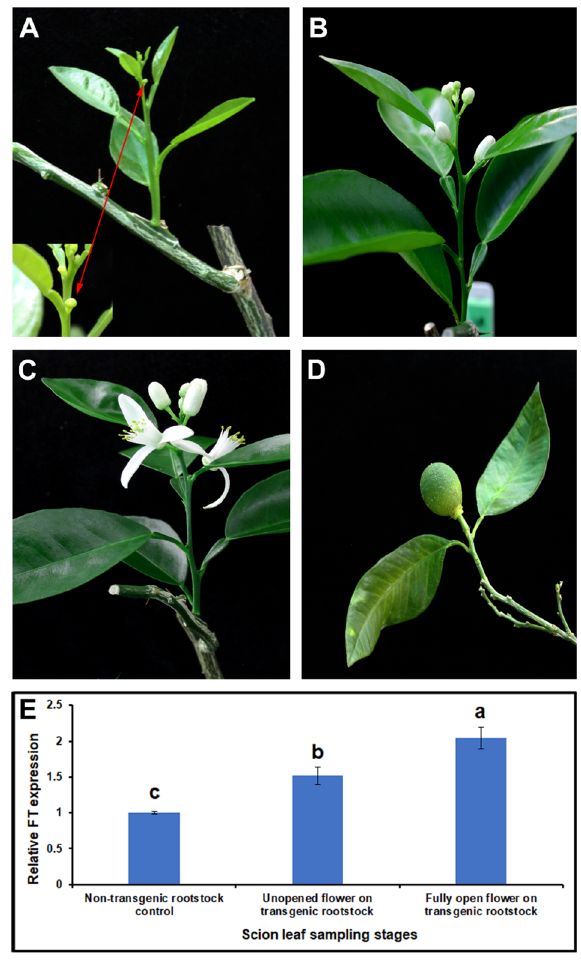
of emerging flower buds ( B ) fully expanded flower buds, ( C ) fully open flowers, ( D ) developing sweet orange fruit and ( E ) relative FT gene expression in the scion leaves at different stages of flowering. Data represent the mean (± standard deviation, SD) of three technical replicates. Different letters represent a significant difference at P < 0.05 using Student’s